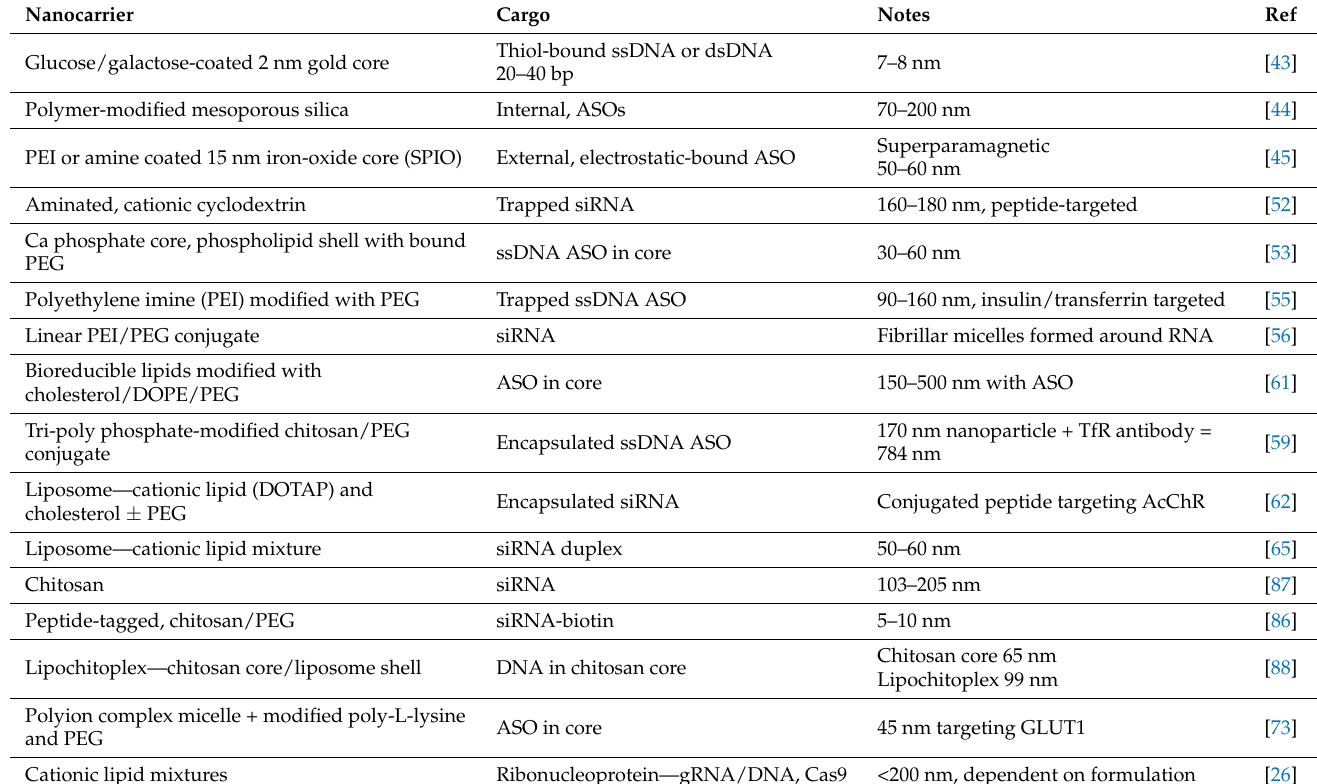
Table 1. Oligonucleotide nanocarriers for delivery to